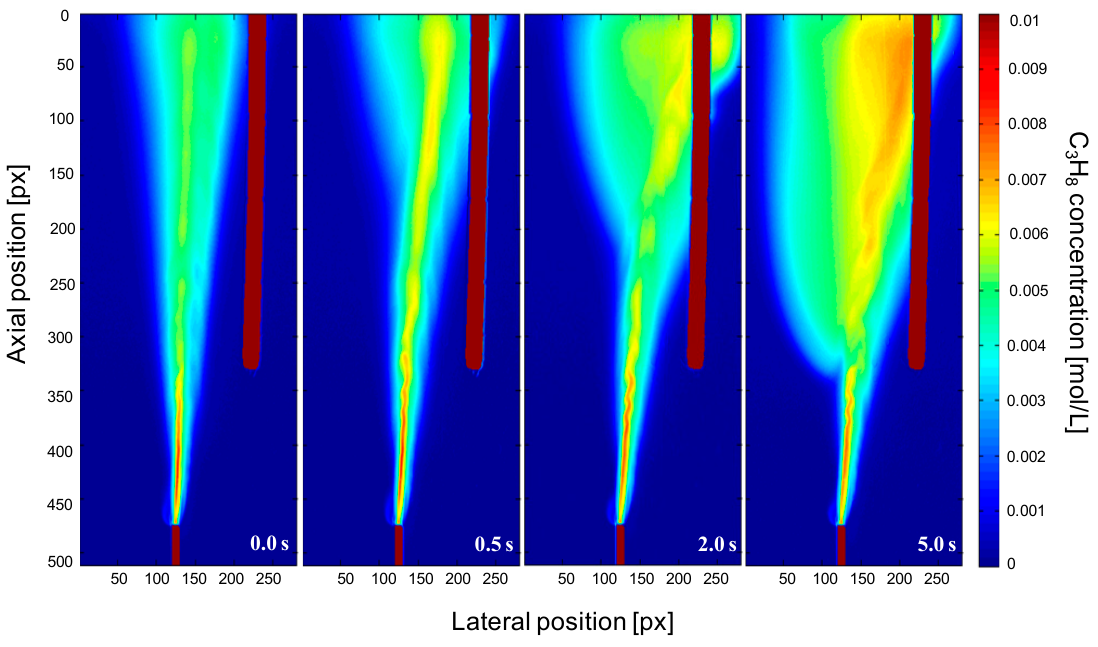
Figure 9. Tracer gas concentration profiles for gas extraction through a porous membrane connected to a vacuum pump using the IR-technique at different moments in time after turning on the vacuum pump.